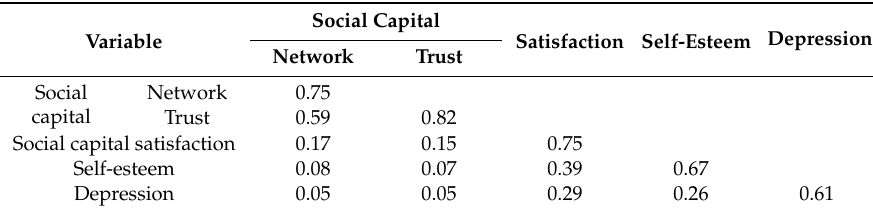
Table 4. Intercorrelations among the latent variables.